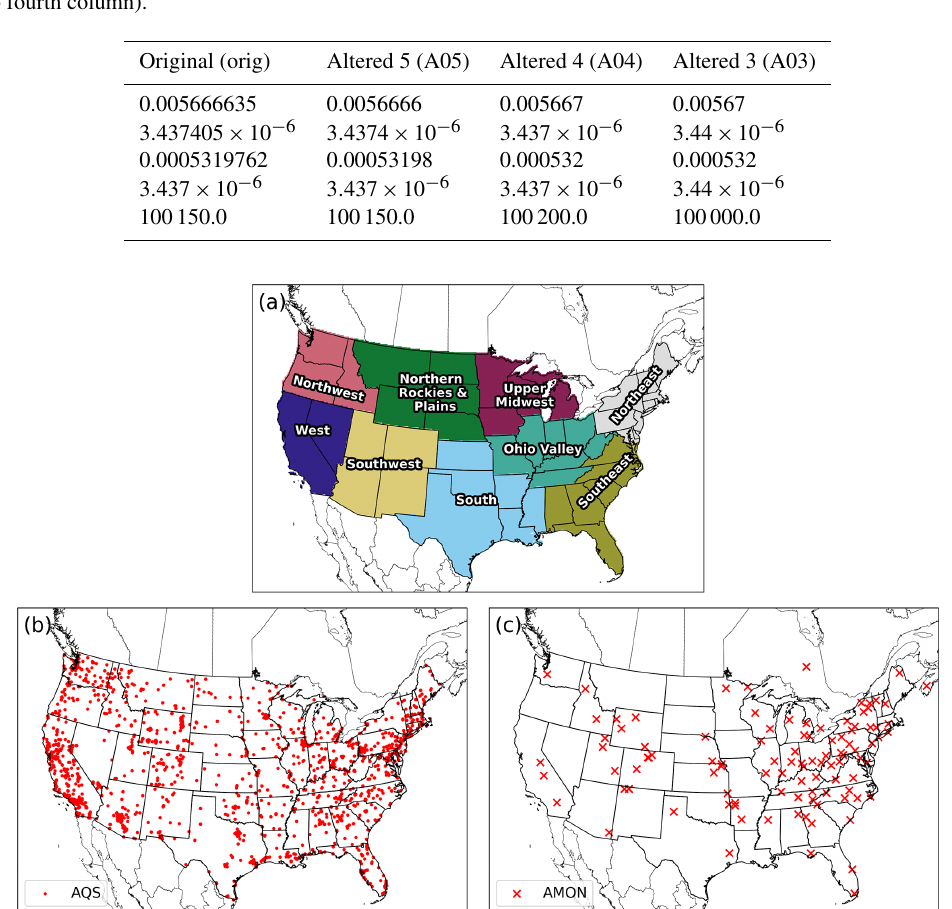
Figure 1. Regions for spatial and temporal stratification (a) , AQS stations (b) , and AMON stations (c) for the proceeding